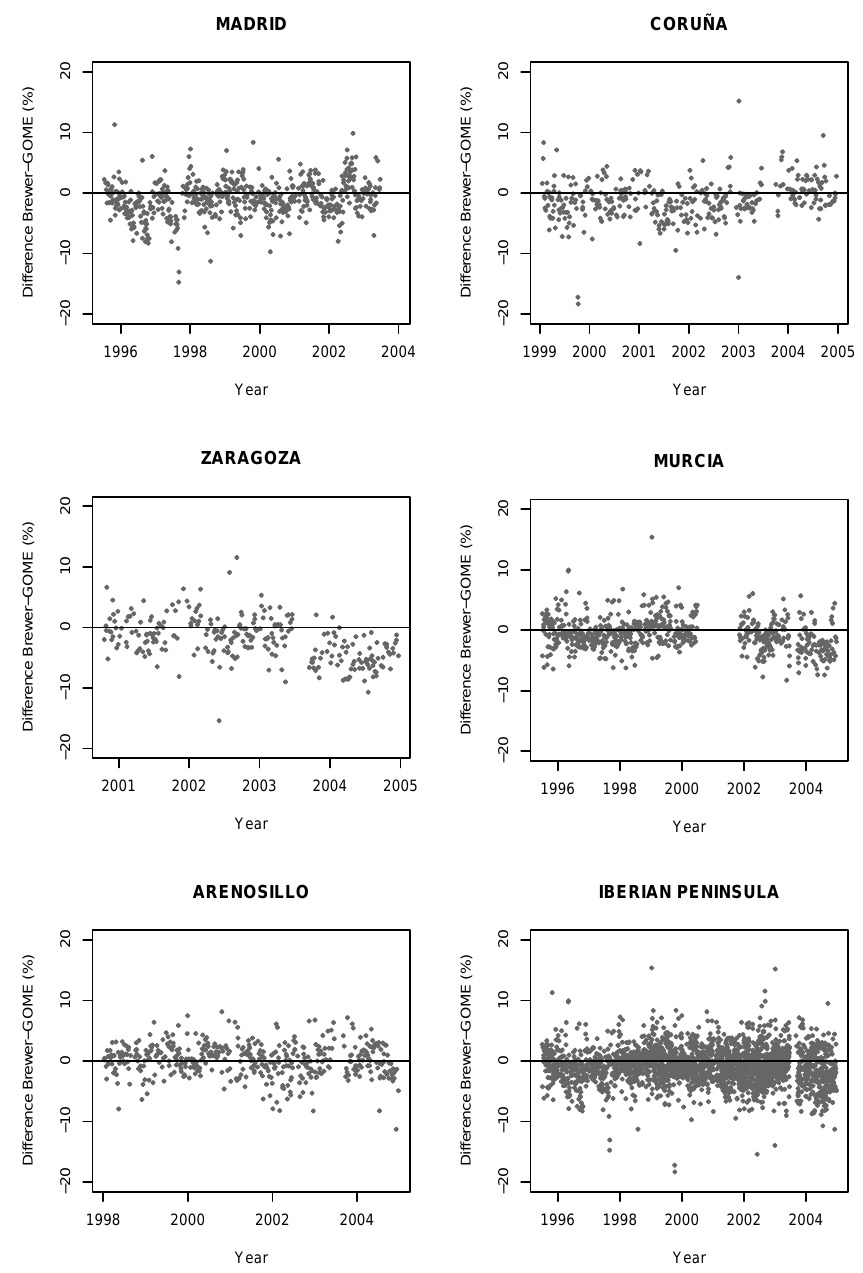
Fig. 3. Temporal evolution of the relative difference between TOMS and Brewer ozone